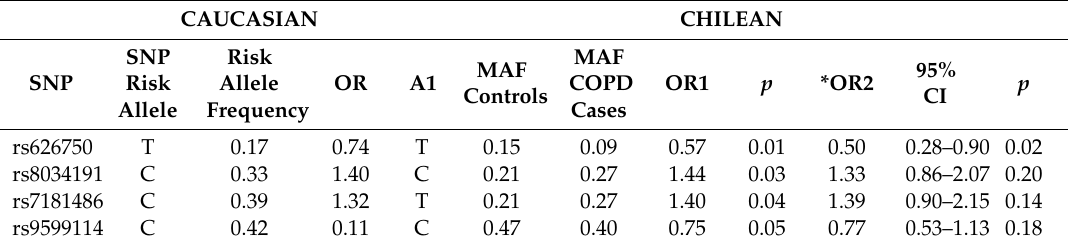
Table 2. Common variants associated with COPD susceptibility in Caucasian and Chilean population (only SNPs with p ≤ 0.05 are